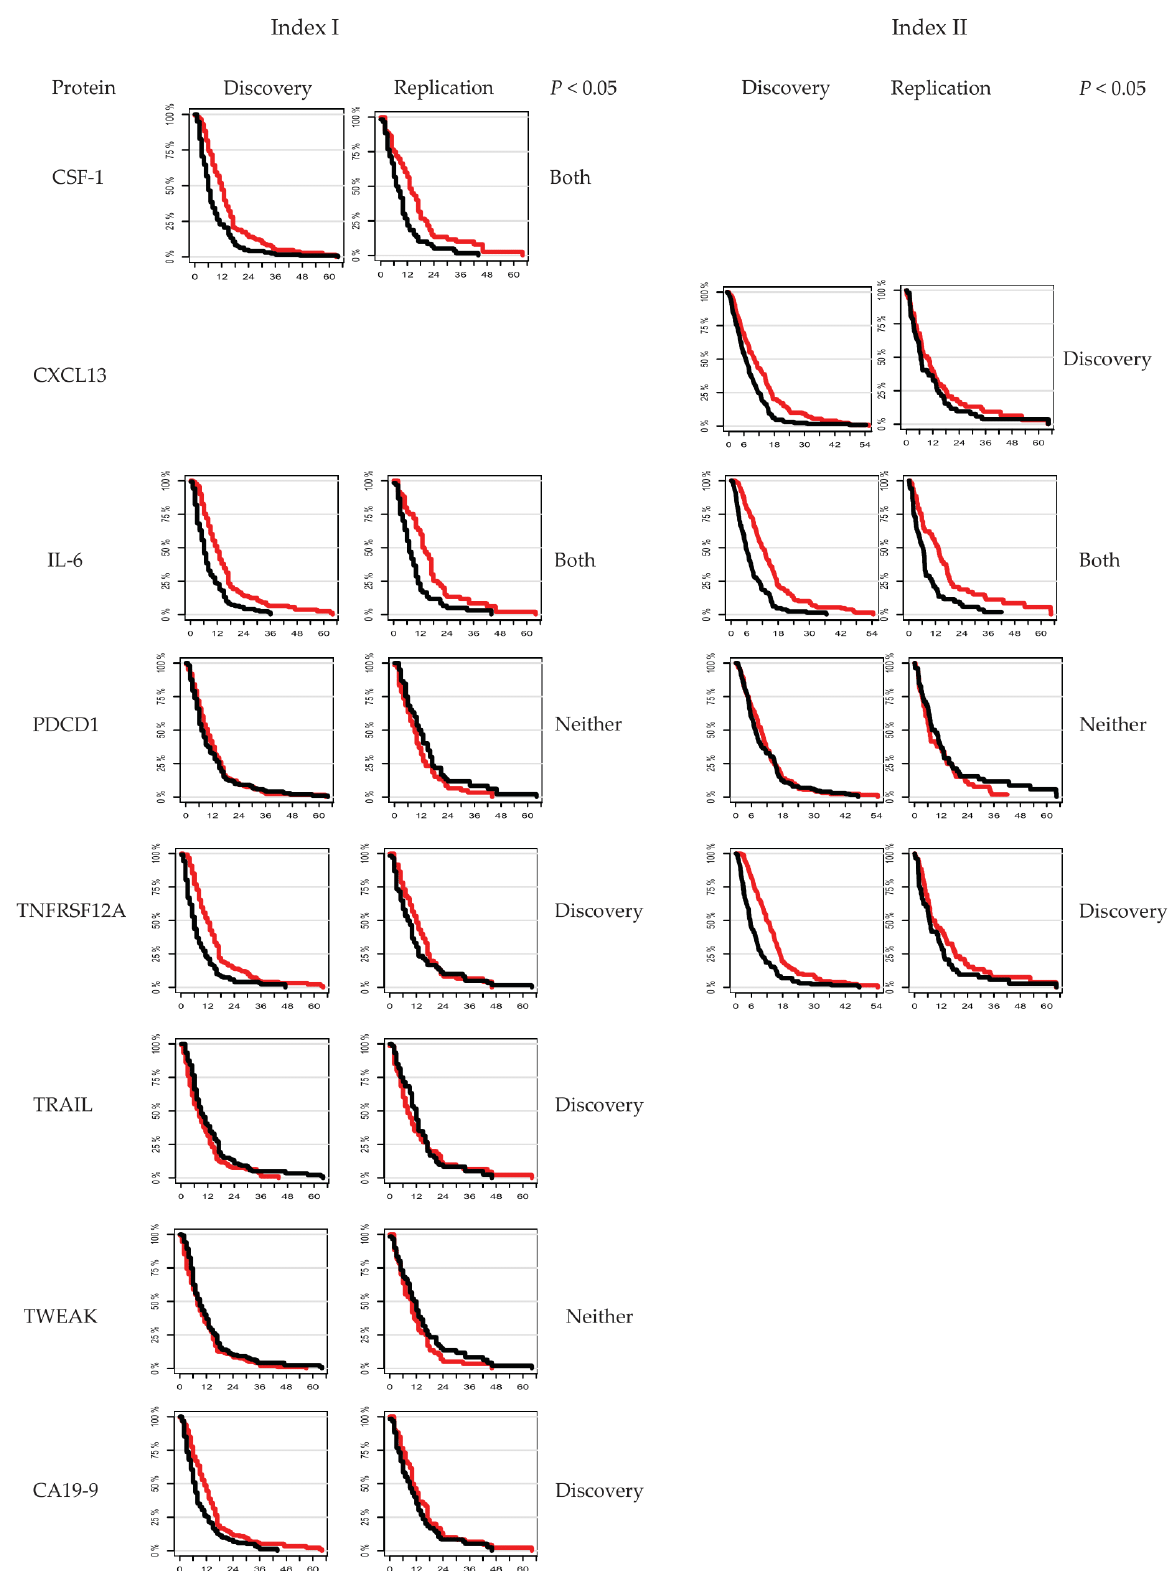
Figure 3. Kaplan – Meier plots showing each of the proteins included in Index I and Index II, and the individual relation to survival. Red curves illustrate <median protein levels, and black curves illustrate >median protein levels.